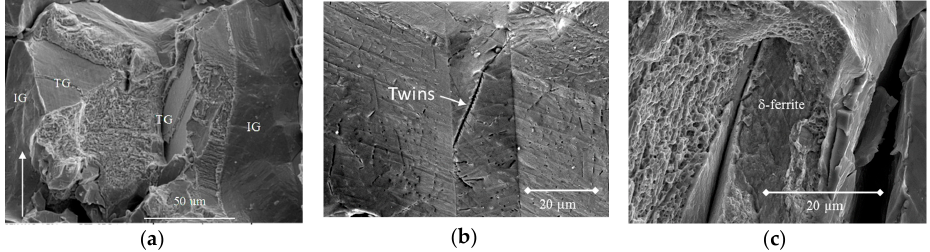
Figure 7. Fracture modes of the 2.4 dpa irradiated 18Cr-10Ni-Ti CT specimen if broken to open in nitrogen vapor at about − 100 °C; arrow indicates the crack growth direction [3]: ( a ) Mixed IG with transgranular (TG) fracture connected by bridges of cleavage and ductile shear; ( b ) Twinning on grain boundary; ( c ) Fracture around a large δ -ferrite particle showing cleavage of the particle and secondary cracks close to ductile ridges.